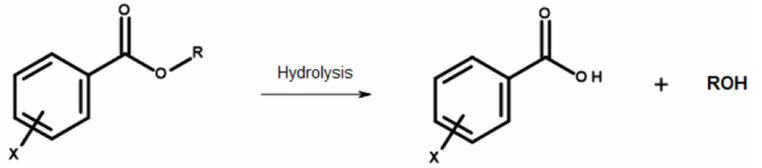
Figure 4. General reaction of the hydrolysis reaction for the benzoic acid derivatives under